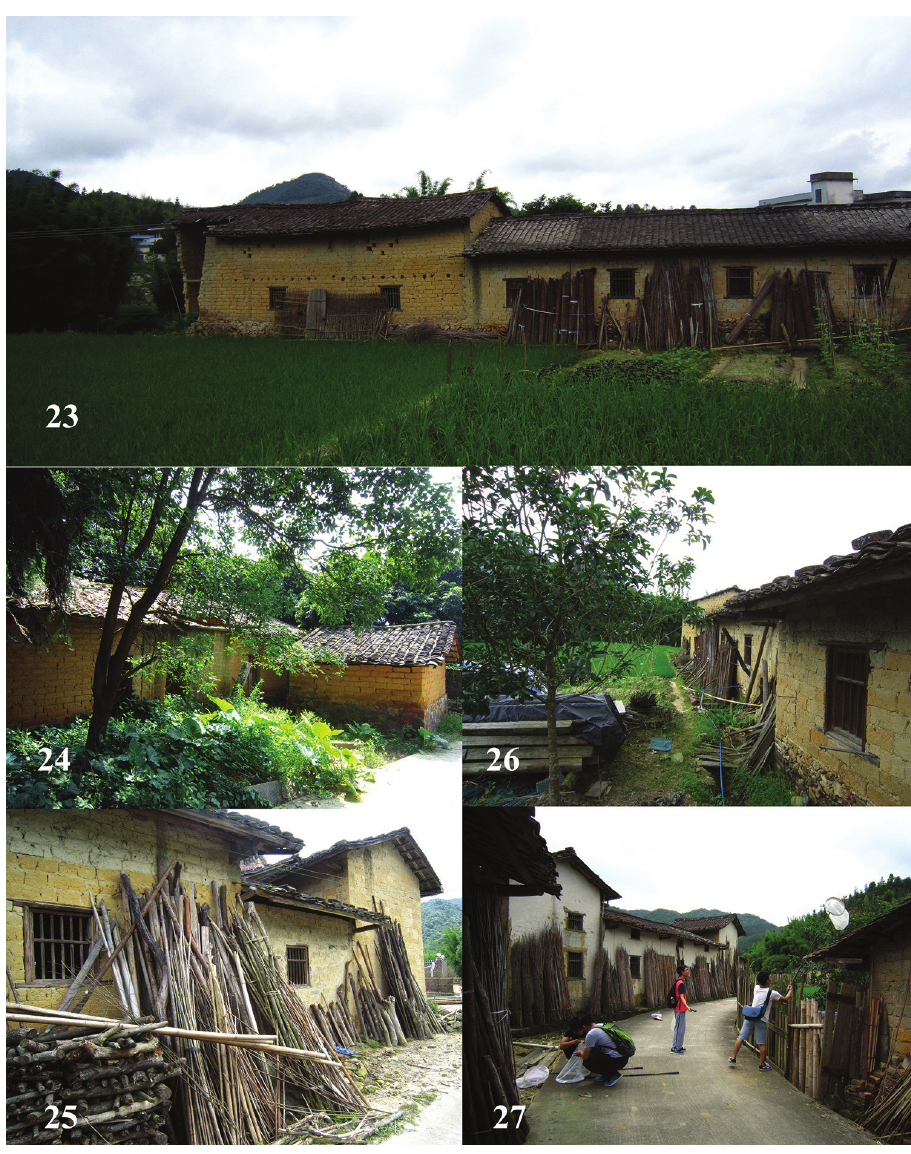
Figures 23–27. Habitats of Leucospis japonica Walker in and moderate-sized punctures (but less densely antero-dorsally), and with short pubes- cence, postero-dorsally lamelliform (Fig. 12). Hind femur with twelve teeth ventrally, basal tooth largest (Fig. 13). Hind tibia produced into a spine ventro-apically (Fig. 5). Metasoma . Metasoma with dense and medium-sized punctures, and with short pubescence. T1 narrower than T4 or T5 in dorsal view. T1 longest and T2 shortest. T1 with smooth double ovipositorial furrow, the latter subdivided by convex, broad